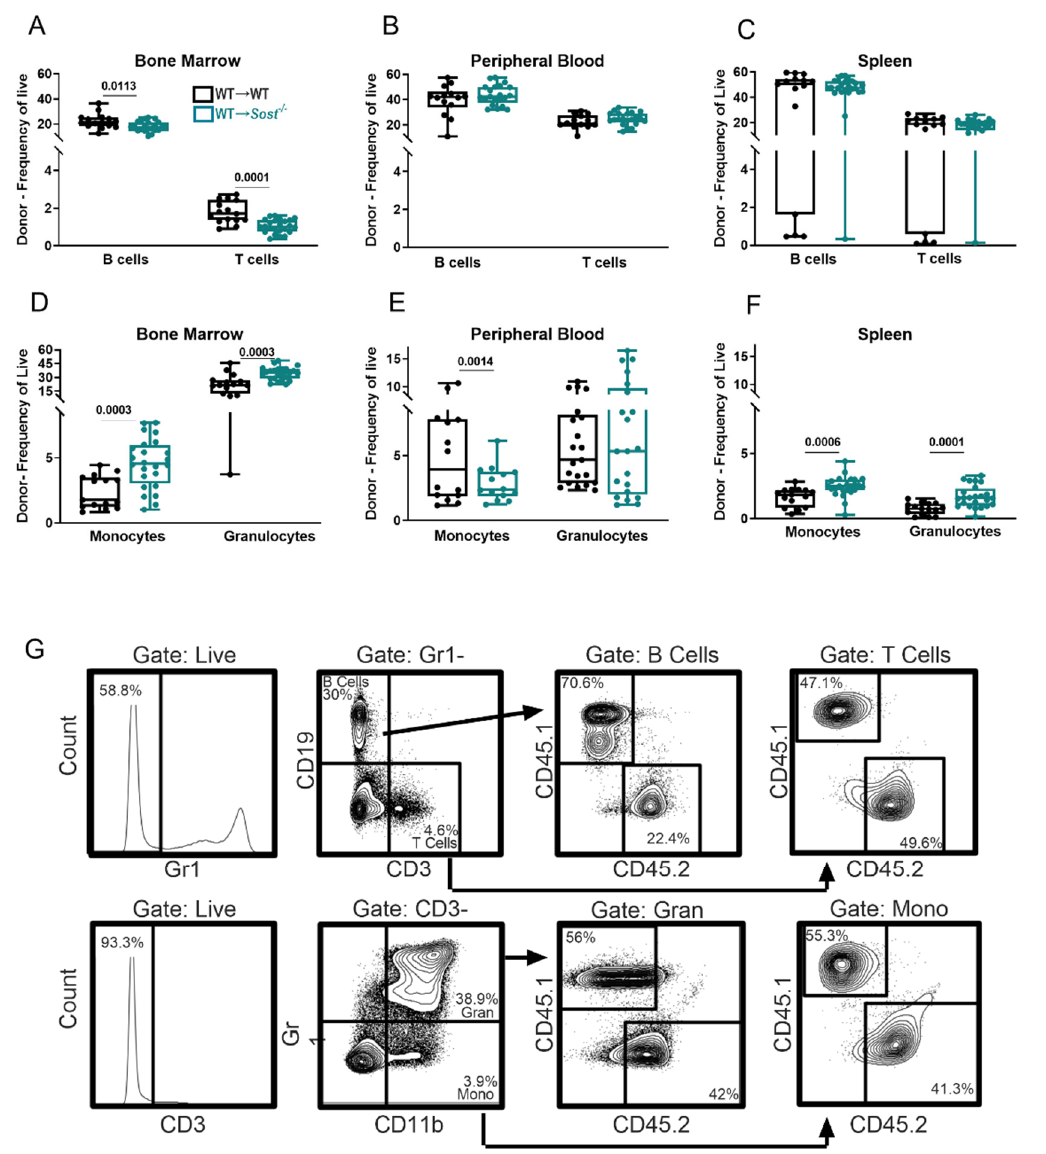
Figure 3. Lack of sclerostin in the bone microenvironment results in a myeloid bias. Frequencies of donor-derived lineage populations in BM ( A ), peripheral blood ( B) , and spleen ( C ) in chimeras; cellularity of donor-derived lineage populations in BM ( D ), peripheral blood ( E ), and spleen ( F ) in chimeras; ( G ) representative FACS plots depicting gating strategy for mature lineages in chimeras. Data shown are from a WT → Sost − / − chimera. Data are from the same experiments described in Figure 2. The actual p -values are shown,